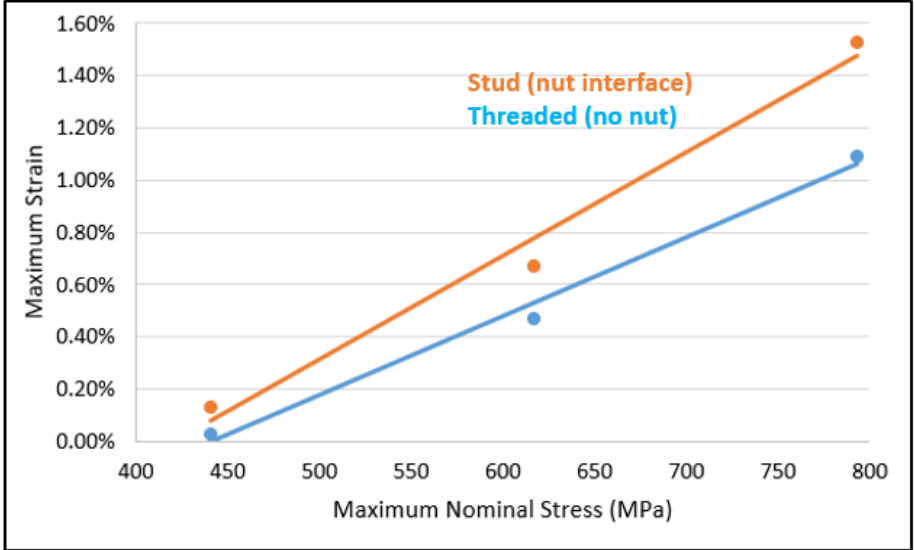
Figure 17. Maximum strain (mm/mm) versus maximum nominal stress.